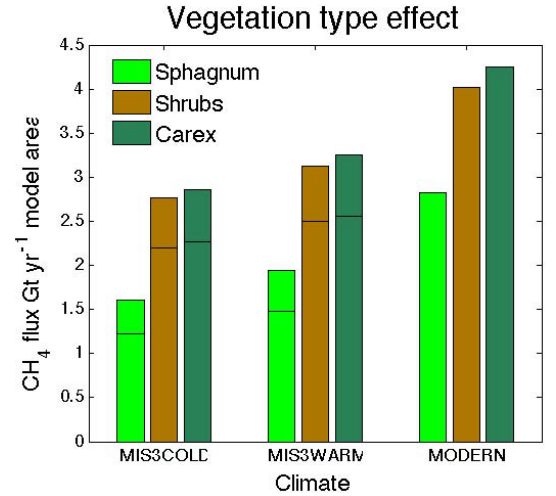
Fig. 5. Fluxes for the wetland vegetation types serving as wetlands vegetation end members, for three modelled climates: MIS3COLD (stadial), MIS3WARM (interstadial), and MODERN (present cli- mate). The horizontal lines in the bars separate the land flux (below the line) and the exposed seafloor flux (above the line) for the MIS3